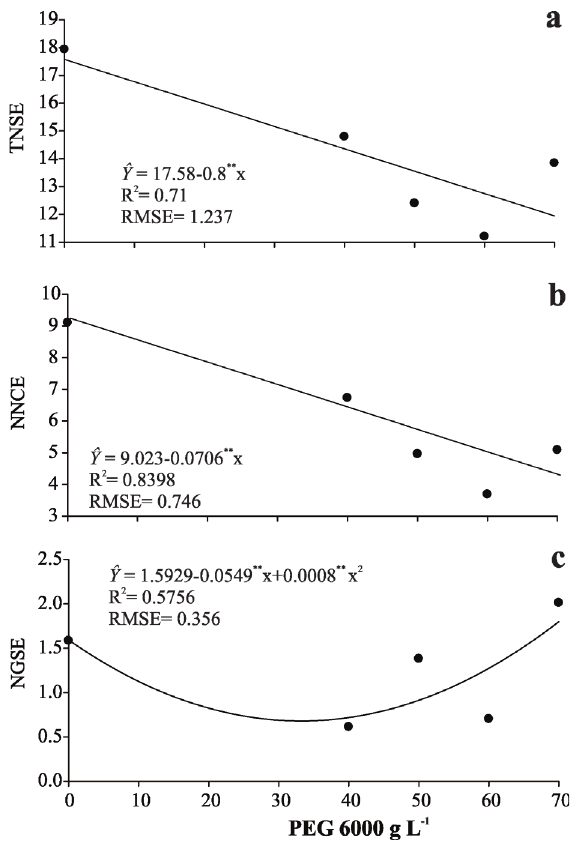
Figure 1 - Total number of somatic embryos ( a ), number of normal cotyledonary embryos ( b ) and number of germinated somatic embryos ( c ) per callus of C . papaya L. ‘Golden THB’, on maturation medium with different concentrations of polyethylene glycol 6000 (0; 40; 50; 60 and 70 g L -1 ) after 45 days of culture. **Significant at p ≤ 0.01 probability level by the F